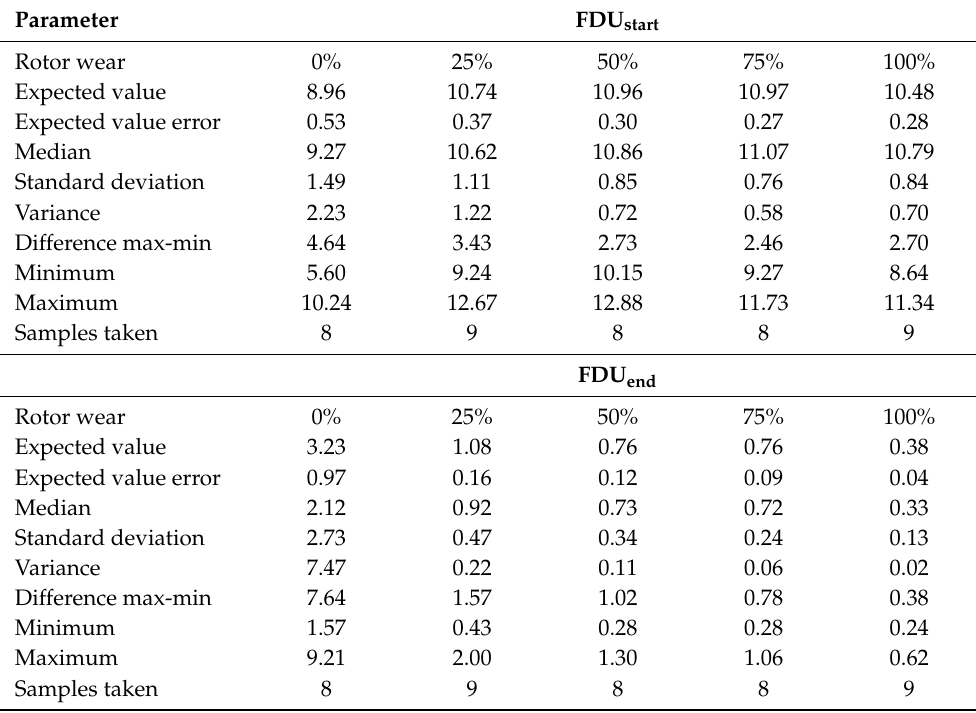
Table 10. Statistical summary of measure values of Dichte Index — type A rotor. Parameter